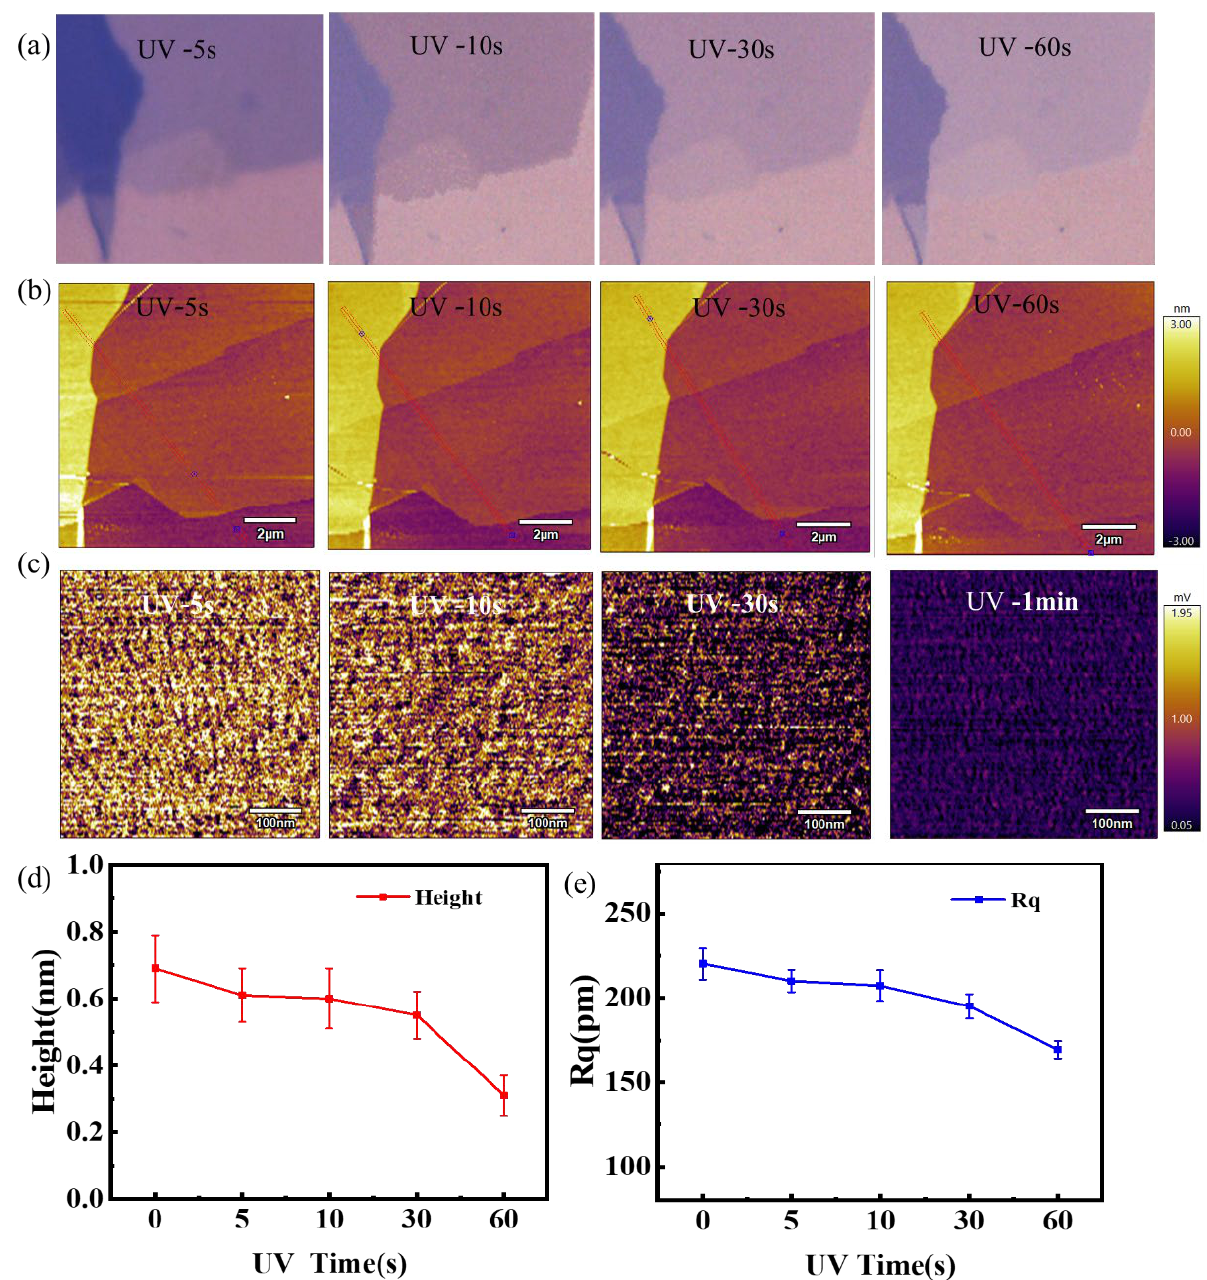
Figure 3. ( a ) Light microscope image of a graphene sample after UV irradiation in vacuum; ( b ) AFM topography map of the corresponding region to ( a ); ( c ) represents the surface sweep friction diagram (10 nN load) of the corresponding single-layer region in ( b ); ( d , e ) represent the variation trend of the height and roughness of monolayer graphene samples with UV vacuum irradiation time, respectively.